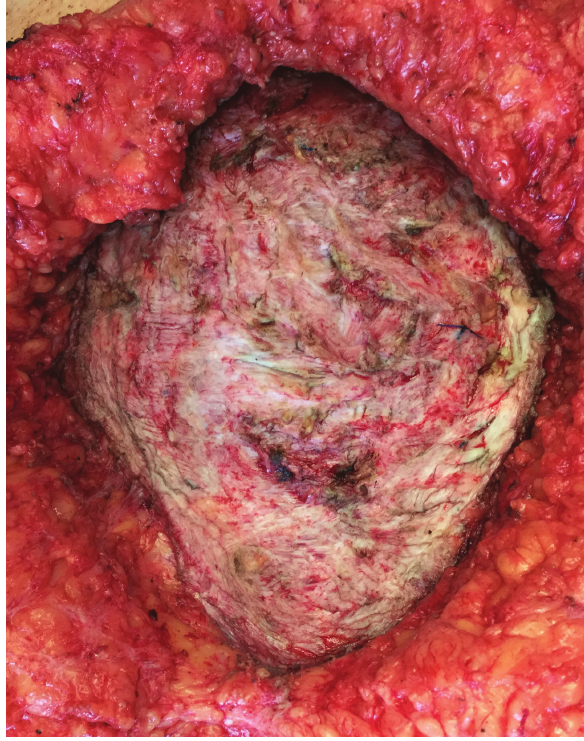
Figure 1: Presentation of the abdomen before the operation